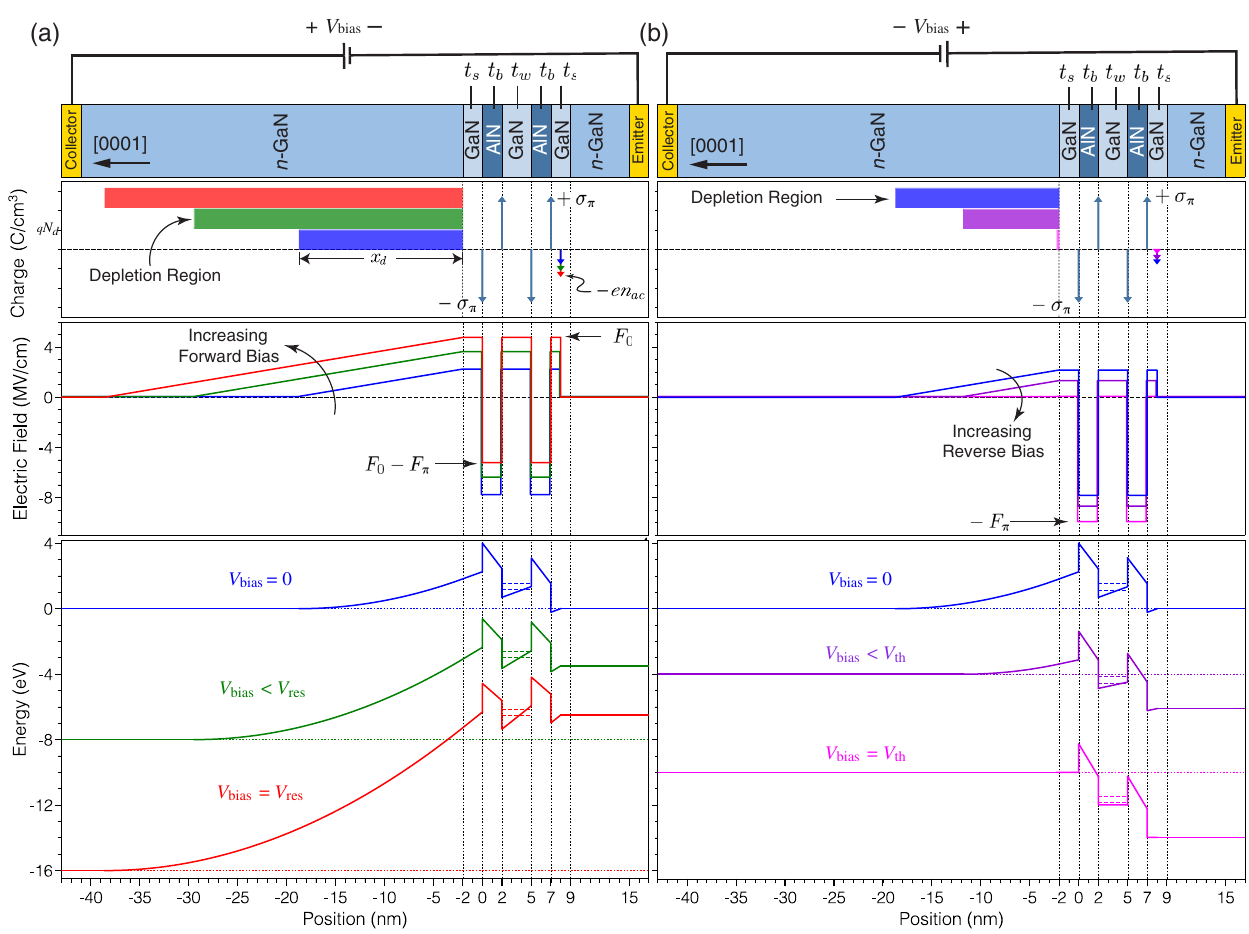
FIG. 5. Distribution of space charge, polarization charge, electric field, and electron energy in a GaN = AlN double-barrier heterostructure under forward and reverse bias. The polarity of the applied bias is that of the collector contact with the emitter as reference. (a) Under forward bias, the depletion region in the collector side becomes wider, causing an increment in the magnitude of the electric field F 0 inside the quantum well. As a consequence, the bound states shift towards lower energies due to the quantum confined Stark effect. Resonant transport arises when the energy of the ground state aligns with the bottom of the conduction band in the emitter side (red curve). (b) Under reverse bias, the collector depletion region becomes narrower while the electric field inside the quantum well tends to zero; at the same time, the electric fields within the barriers increase in magnitude. With a narrower depletion layer, electrons supporting the reverse current require less energy to reach the collector barrier and tunnel into the emitter region. A critical condition is achieved when the depletion region vanishes. Under this configuration, the threshold voltage V is dropped across both barriers, which th support an internal electric field equal to the polarization field F π (magenta